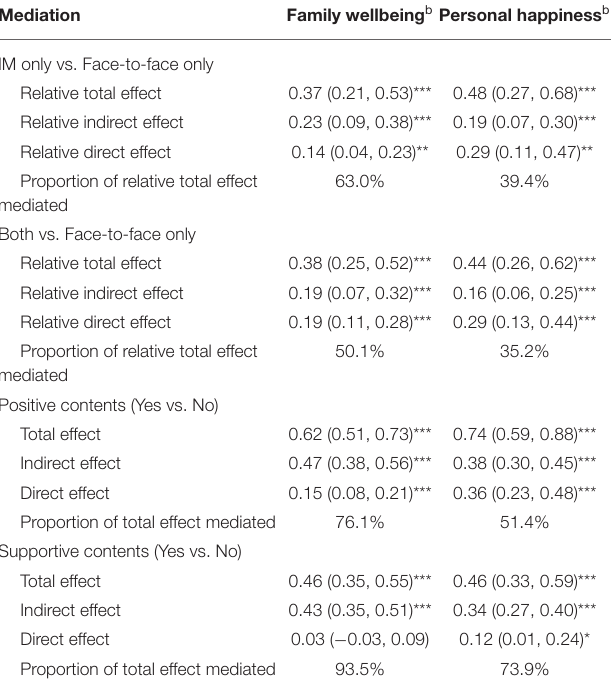
TABLE 4 | Adjusted total, indirect, and direct effects of communication methods and positive and supportive contents on outcomes mediated by family communication quality, adjusted β (95% CIs) ( n = 4,571) a .